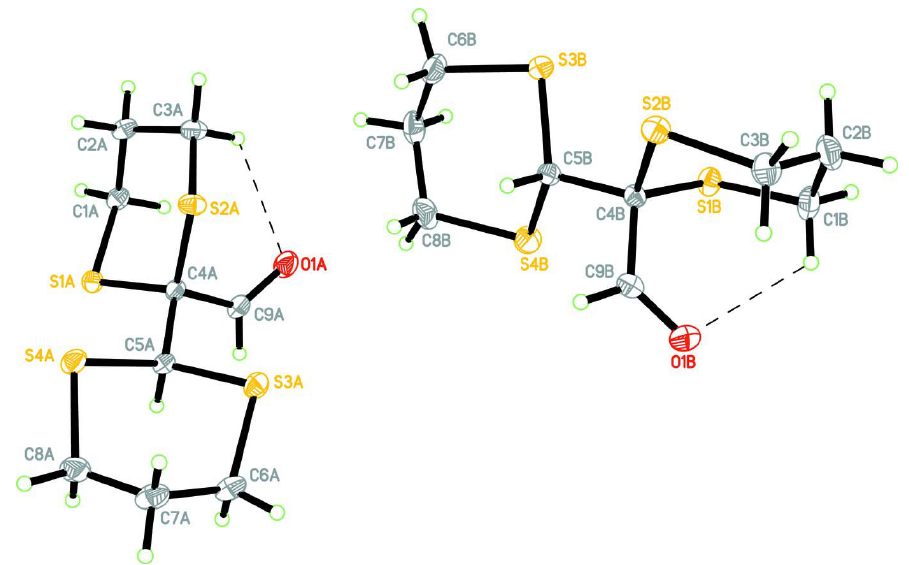
Figure 1 The molecular structure of (I), showing 50% probability displacement ellipsoids and the atomic numbering. Dashed lines show intramolecular hydrogen